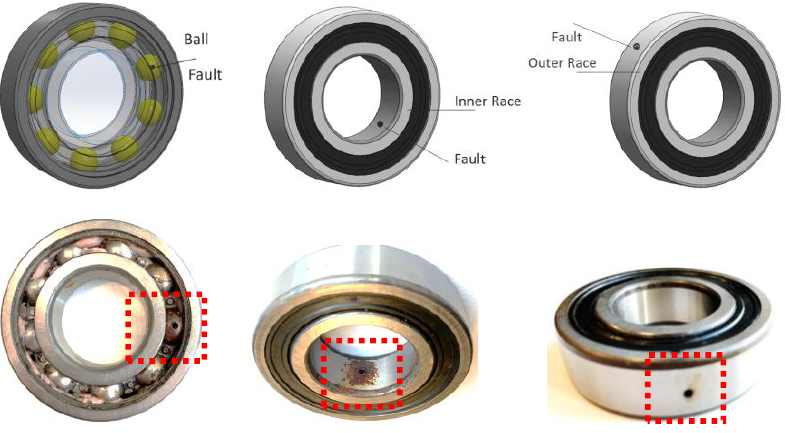
Figure 6. The real-time multisensory fault diagnosis.